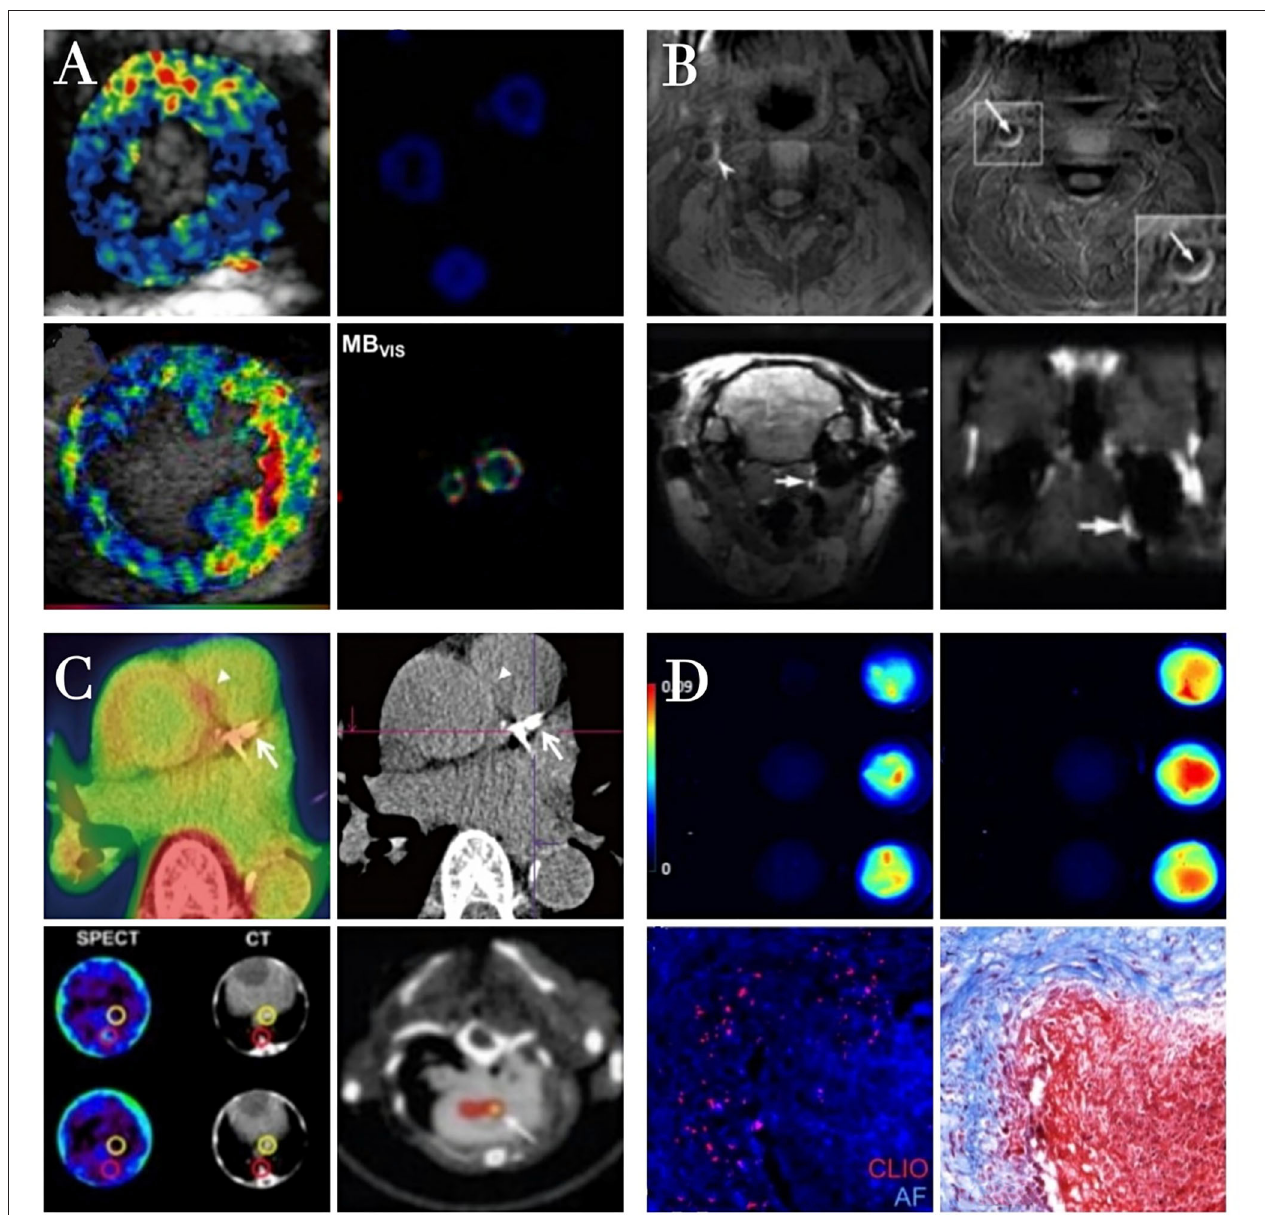
FIGURE 3 | The characteristics of different molecular imaging approachs. Ultrasound molecular imaging of thrombosis (A) . Color-coded ultrasound molecular signal overlays indicate that targeted MBs yield a specific signal only in the presence of thrombin. Reproduced with permission from Yan et al. (83). Copyright Theranostics. 2018. Magnetic resonance imaging of thrombosis (B) . The high MR signal area of thrombi is significantly increased after contrast agent injection in the presence of atherosclerotic plaques Reproduced with permission from Zhang et al. (92). Copyright Int J Nanomedicine (2019). Radionuclide imaging of thrombosis (C) . Fibrin-binding peptides coupled to radioactive tracers specifically interacting with arterial thrombi as detected in PET/SPECT images. Reproduced with permission from Lee et al. (120). Copyright Korean J Radiol (2015). Optical imaging of thrombosis (D) . Fluorescence imaging of nanoparticles binding to fibrin clots formed from fibrinogen and thrombin. Reproduced with permission from Wen et al. (121). Copyright J Mater Chem B